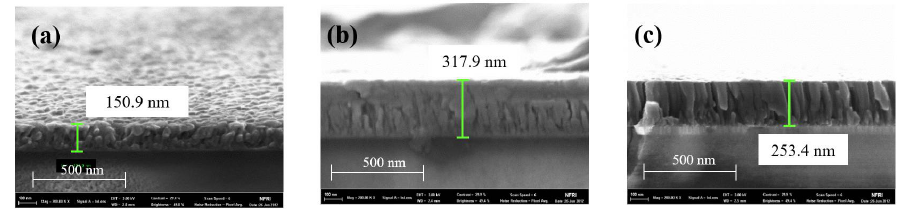
Figure 7. Cross-sectional FESEM images of Ti thin films deposited at a sputter voltage of − 600 V and extractor voltages of ( a ) 0, ( b ) 100, and ( c ) 200 V.